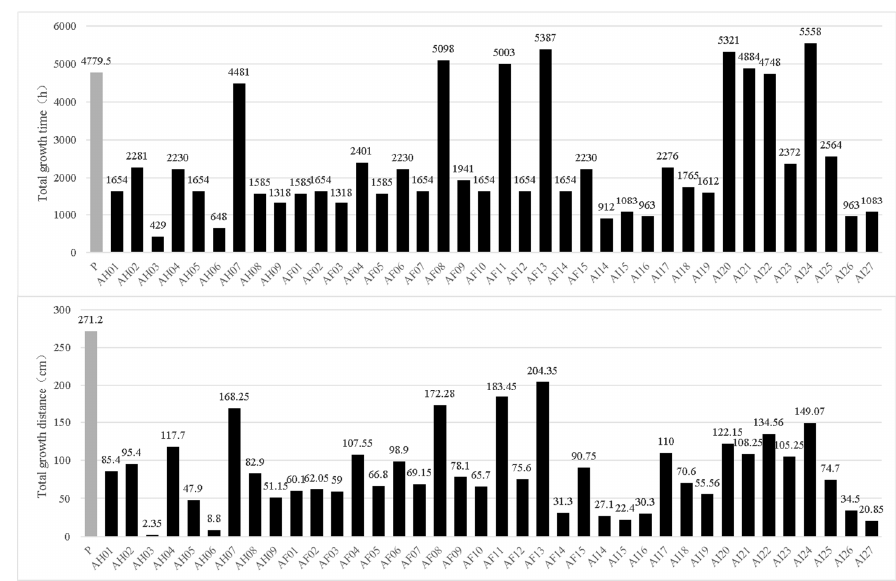
Figure 5. Longevities of the 38 mitospore-germinated strains of M. sextetala compared with those of their parental strains (P), shown as the total accumulated growth time ( above ) and total accumulated growth distance ( below ) after subculturing. Microorganisms 2023 , 11 , x FOR PEER REVIEW